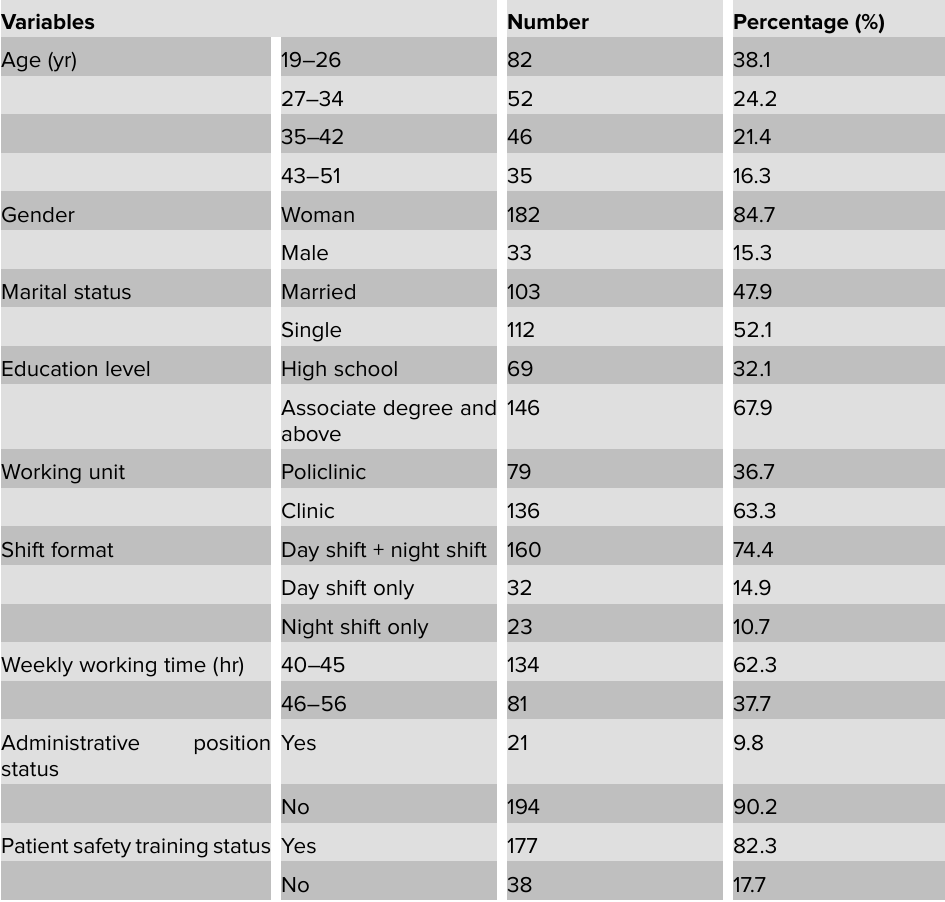
Table 2: Descriptive statistics of the participants.